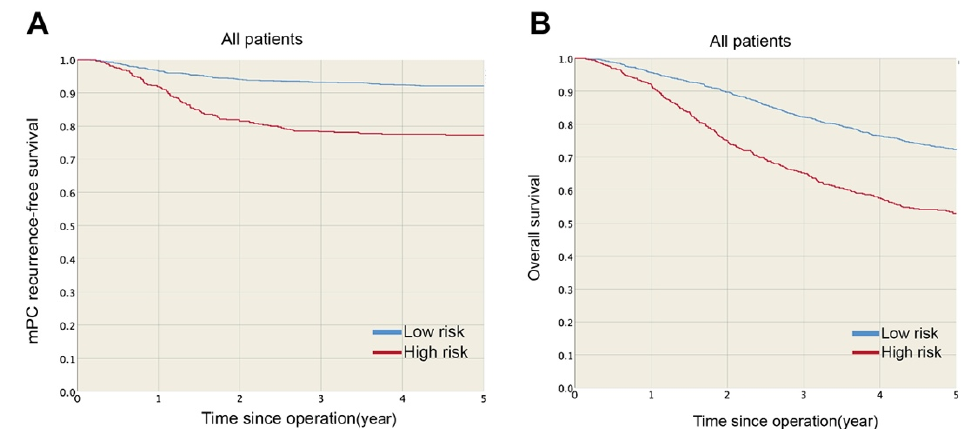
Figure 2. ( A ) mPC recurrence-free survival and ( B ) overall survival were significantly higher in low-risk than high-risk group.